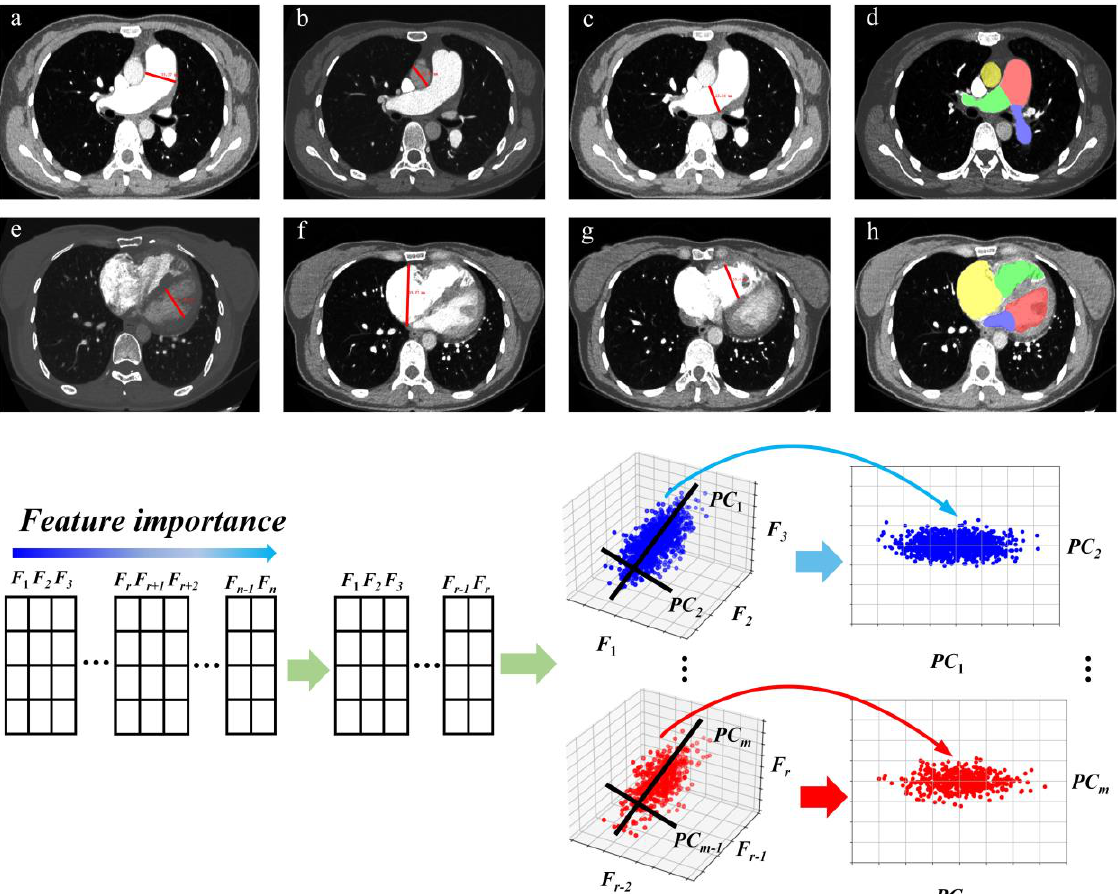
Figure 3. Some of the morphological features on CTPA are shown above. ( a ) Diameter of main pulmonary artery (MPAd), ( b ) diameter of ascending aorta (AAd), ( c ) diameter of right pulmonary artery (RPAd), ( d ) area of LPA (blue), RPA (green), MPA (red), and AA (yellow), ( e ) diameter of left ventricle, ( f ) diameter of right atrium, ( g ) diameter of right ventricle, ( h ) area of LV (red), RV (green), LA (blue), and RA (yellow). They were all assessed on transversal images in the diastole. The features extracted from the original CTPA images were first organized in a table, sorted by the Spearman’s rank correlation coefficient between one feature and mean pulmonary artery pressure. Since any two features we selected may contain a strong correlation, we removed redundant features by calculating the Pearson coefficient of all features with each other. Then we selected r features from all features we obtained. The considerately selected features were then normalized and feature dimension reduction was performed by principal component analysis. Finally, we chose m features for the regression and classification model.